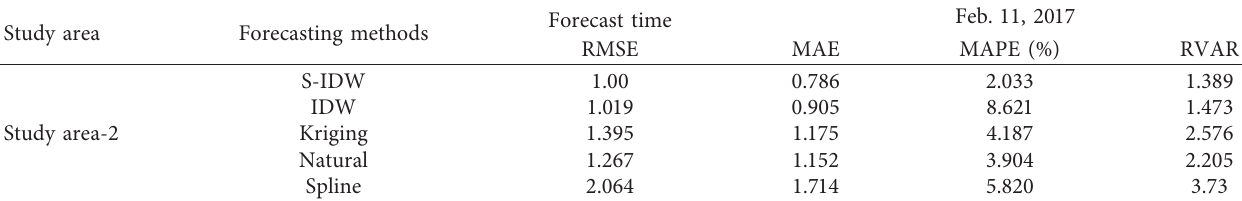
Table 13: Comparison of interpolation accuracy of 5 kinds of interpolation methods on Feb. 11,